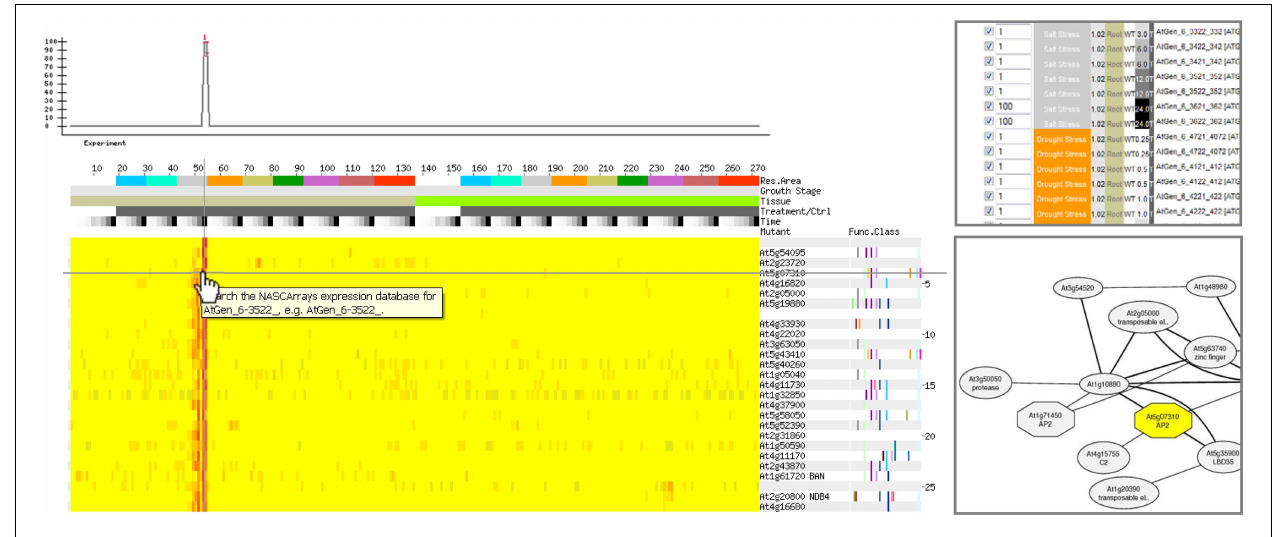
FIGURE 1 | A gene may be identified having an expression pattern as shown in the top left. Alternately, a vector can be designed that exhibits a desired behavior. Coexpression analysis on an abiotic stress compendium produced by Kilian etal. (2007) returns genes exhibiting similar patterns of expression. In this example, only genes exhibiting strong expression in roots after 24 h of exposure to salt as specified using the AtGenExpress Stress Set and Expression Angler (Toufighi etal., 2005) running in the Subselect and Custom Bait mode (top right), are returned by the analysis, as shown in the